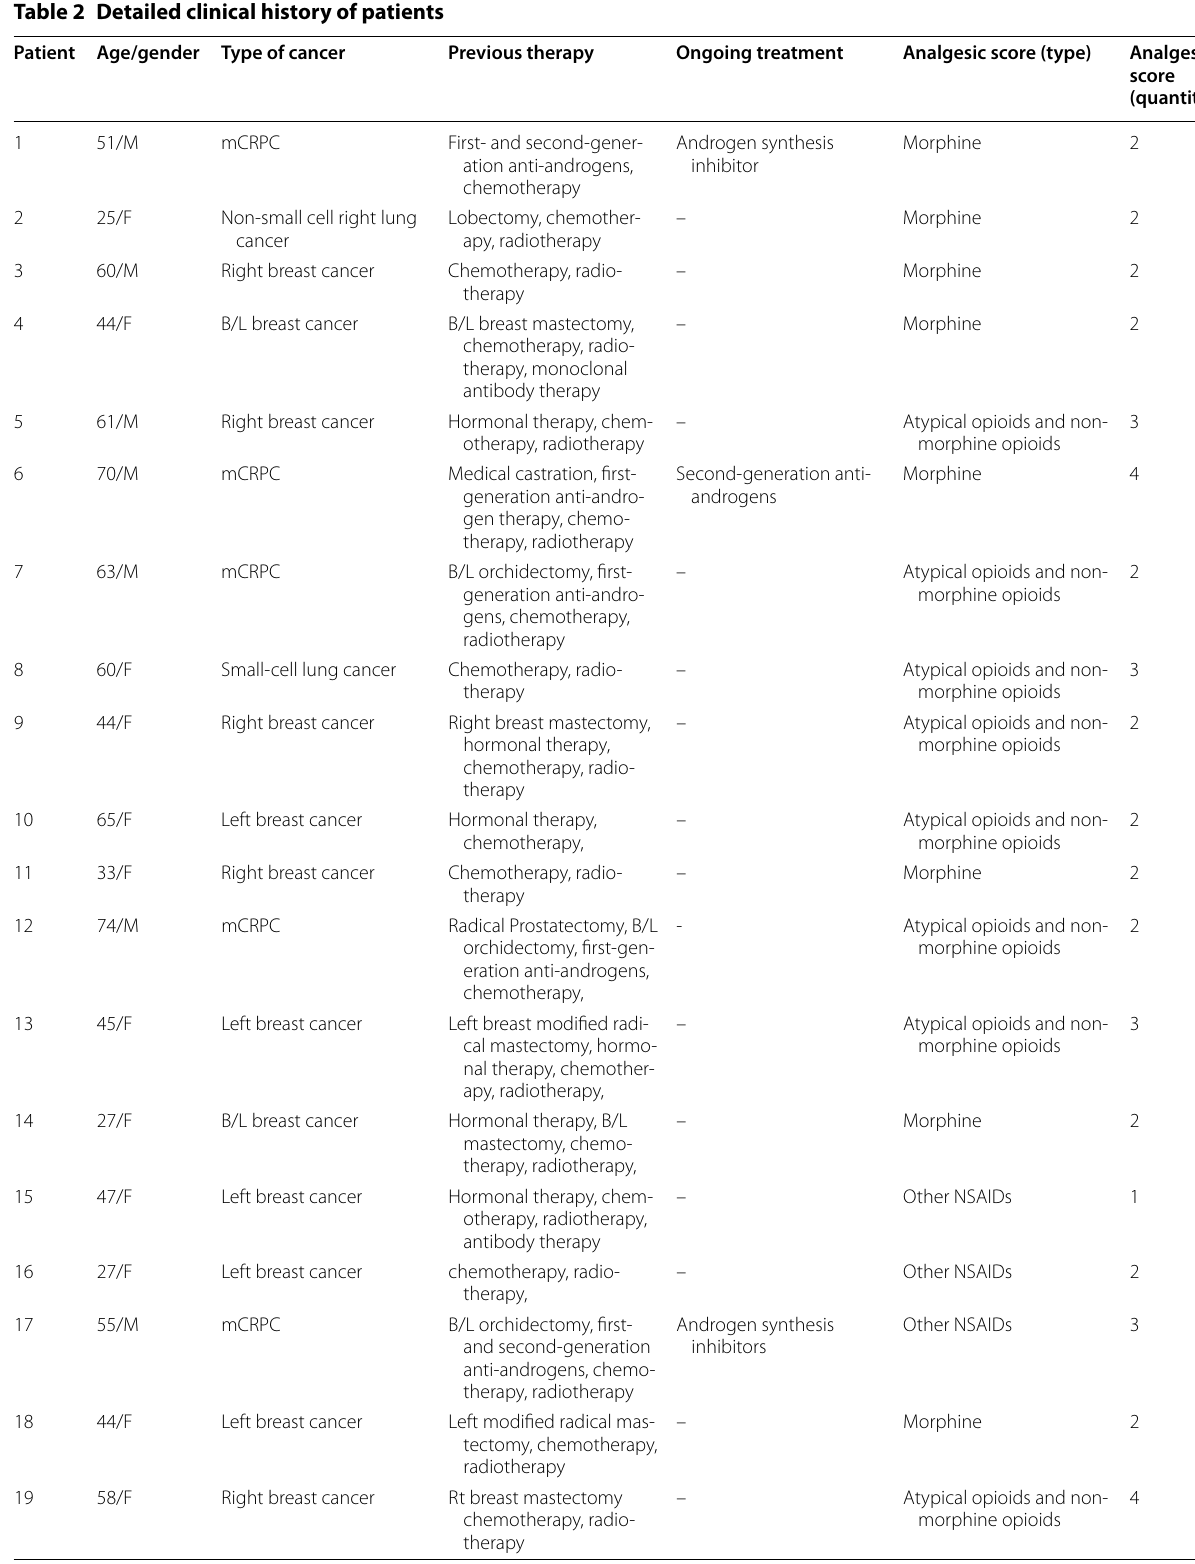
Table 2 Detailed clinical history of patients Patient Age/gender Type of